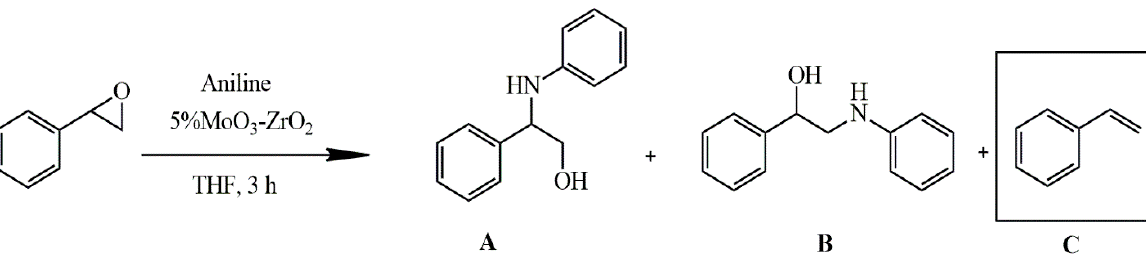
Table 3. A direct comparison of effectiveness of 5%MoO 3 -ZrO 2 on the aminolysis of styrene oxide with aniline and those catalyst reported in the literature. Catalyst